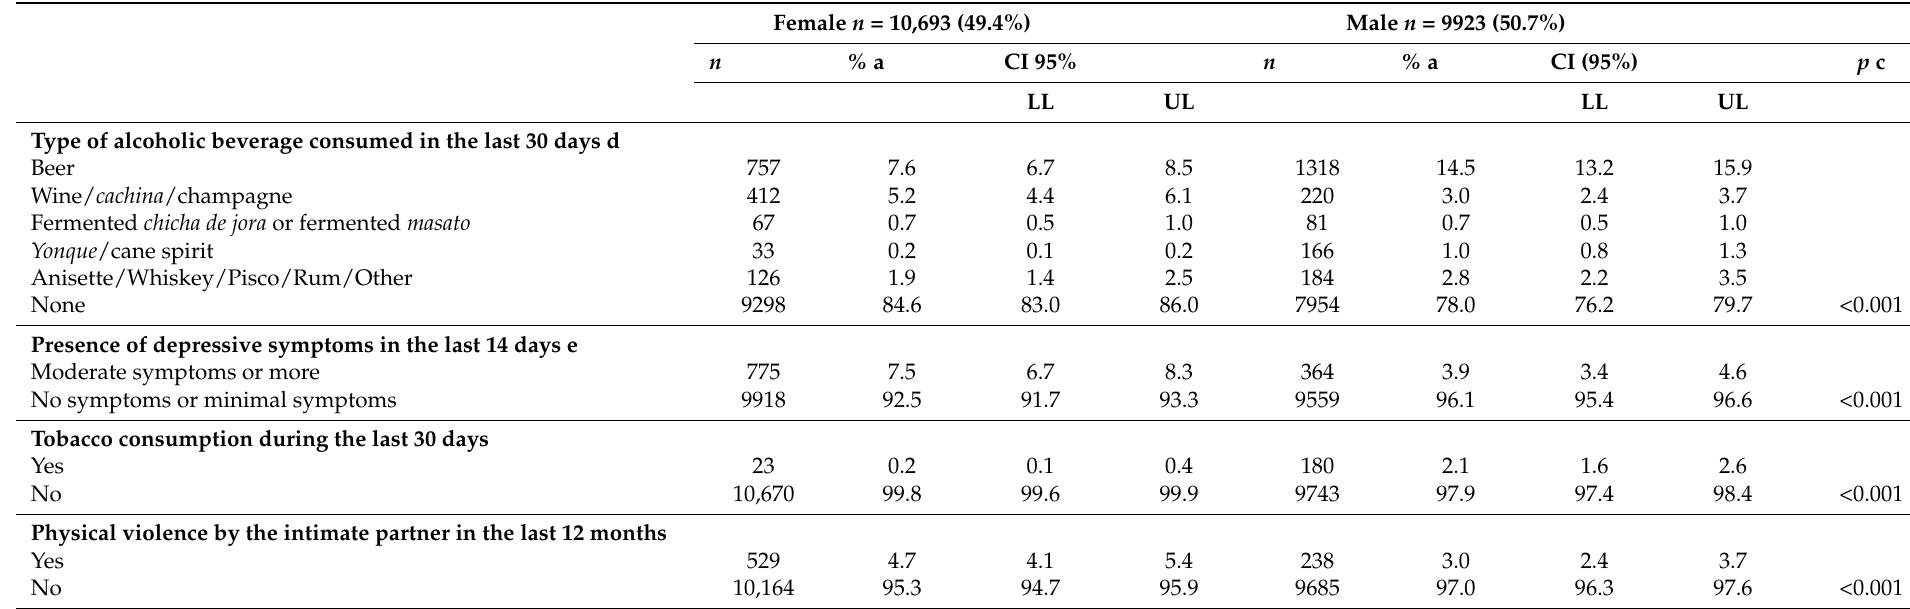
Table 2. Problem behaviors according to sex in the population older than 15 years of age in Peru 2020 ( n =